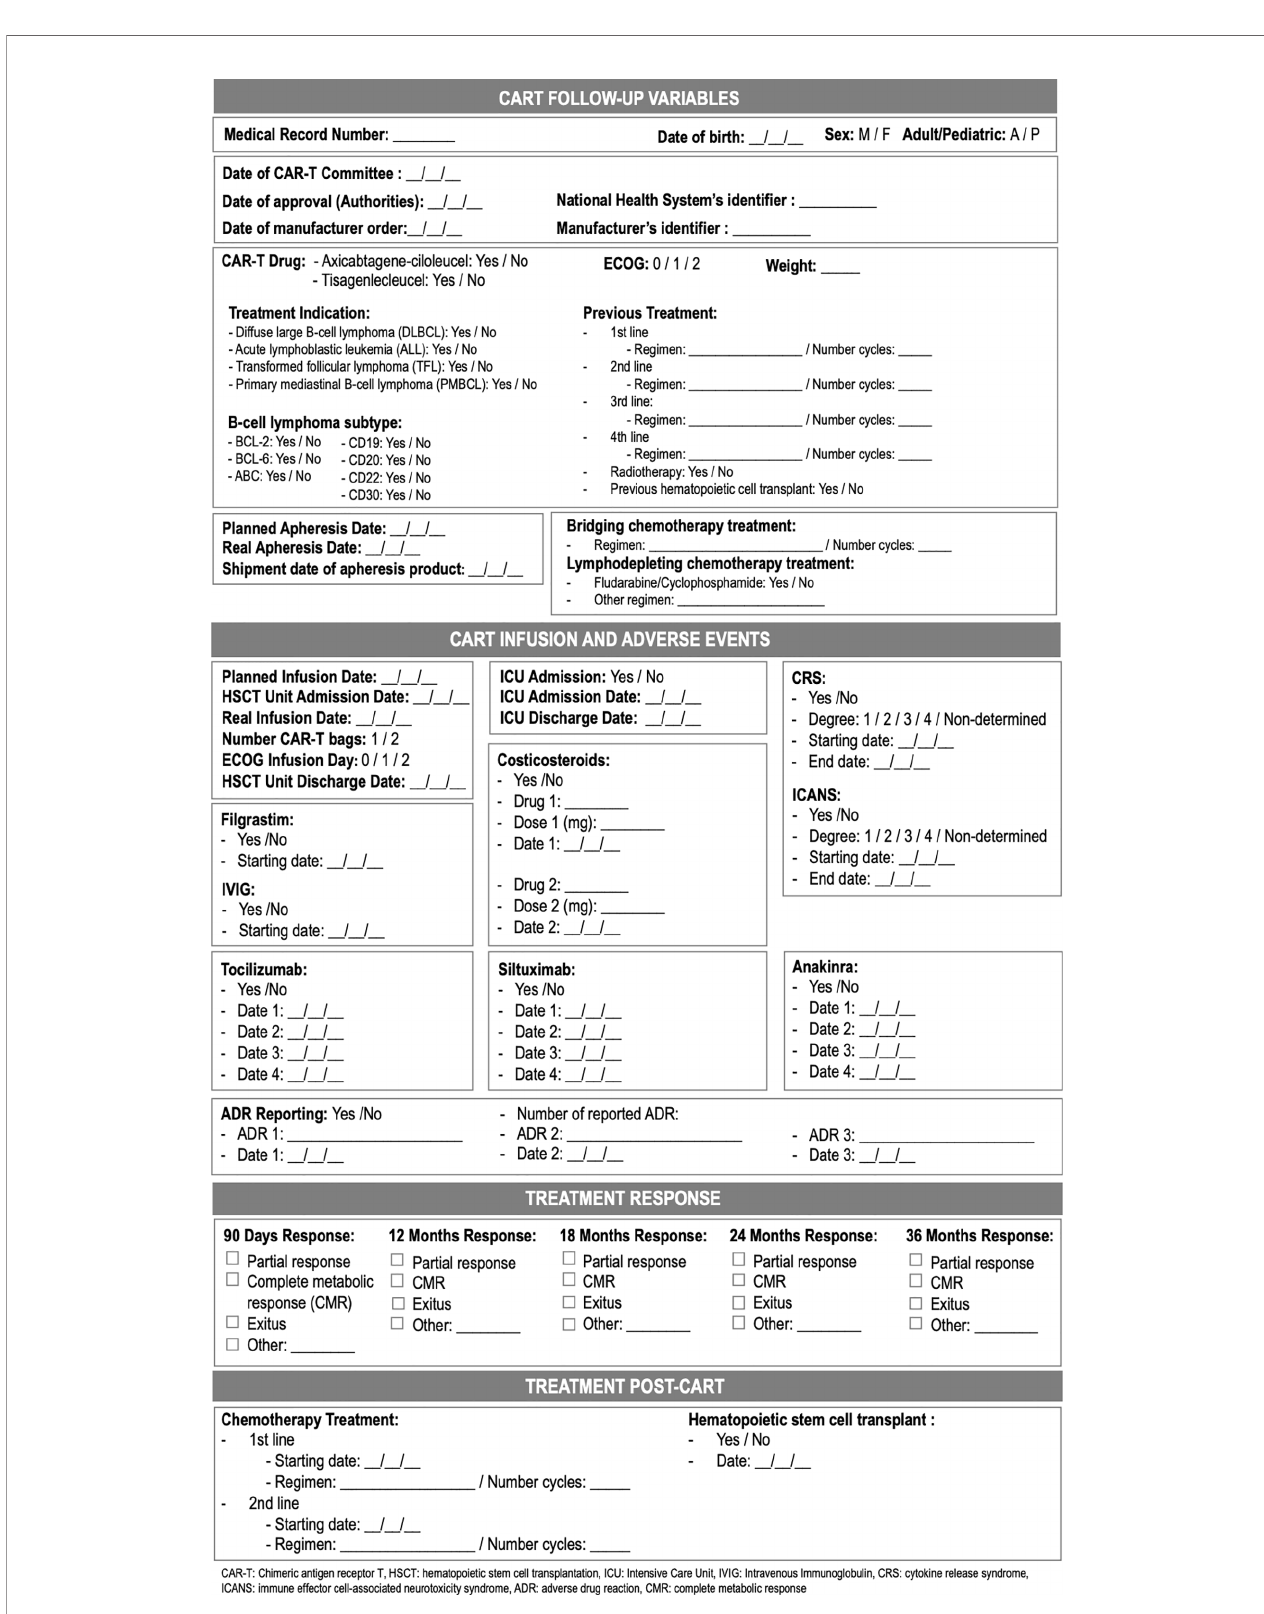
FIGURE 2 | Recorded variables for outcomes ’